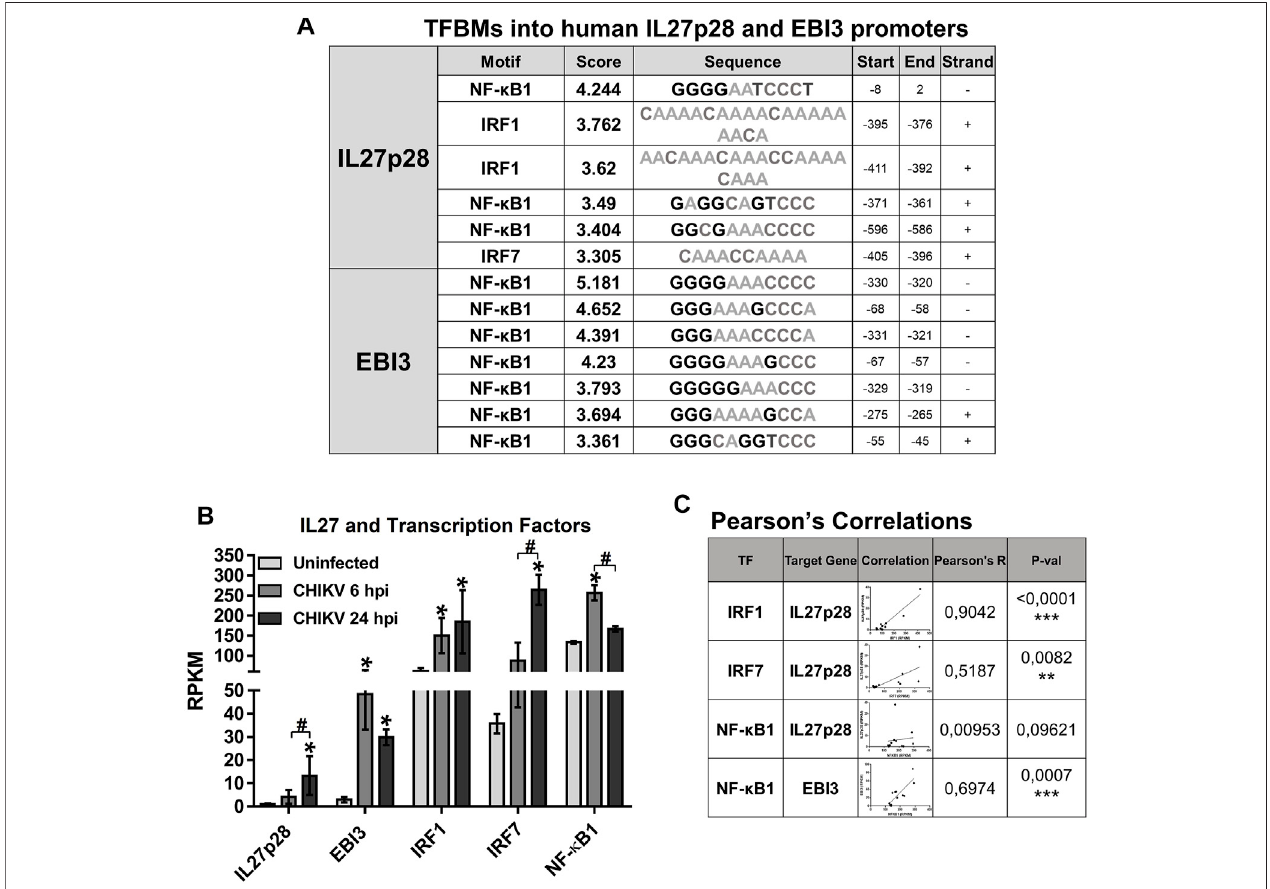
FIGURE 2 | The human encoding genes for IL27p28 and EBI3 have differential transcriptional regulation. TFBM analysis was performed on promoters ( − 600 and +50 relative to TSS) of human IL27p28 and EBI3 genes using HOMER software. TFBM on the promoter of human IL27p28 and EBI3 genes (A) . Human MDMs cultures were left uninfected or infected with CHIKV at MOI 5. Cell lysates were obtained at 6 and 24 hpi and RNA-seq was performed. mRNAs abundance (RPKM) of IL27 subunits (IL27p28 and EBI3) and transcription factors (IRF1, IRF7 and NF- κ B1) in uninfected and CHIKV-infected MDMs (B) Data are presented as the mean ± SEM.Kruskal – WallistestwithDunn ’ spost-testwasperformed.Signi fi cantresultsbetweenuninfectedandCHIKV-infectedMDMsarede fi nedas p < 0.05(*), p < 0.01(**) and p < 0.002 (***). n = 4. Pearson ’ s correlation between transcription factors (IRF1, IRF7 and NF- κ B1) and IL27 subunits (IL27p28 and EBI3) mRNAs abundance (RPKM) in uninfected and CHIKV-infected MDMs (C) . Signi fi cant results are de fi ned as p < 0.05 (*), p < 0.01 (**) and p < 0.002 (***).